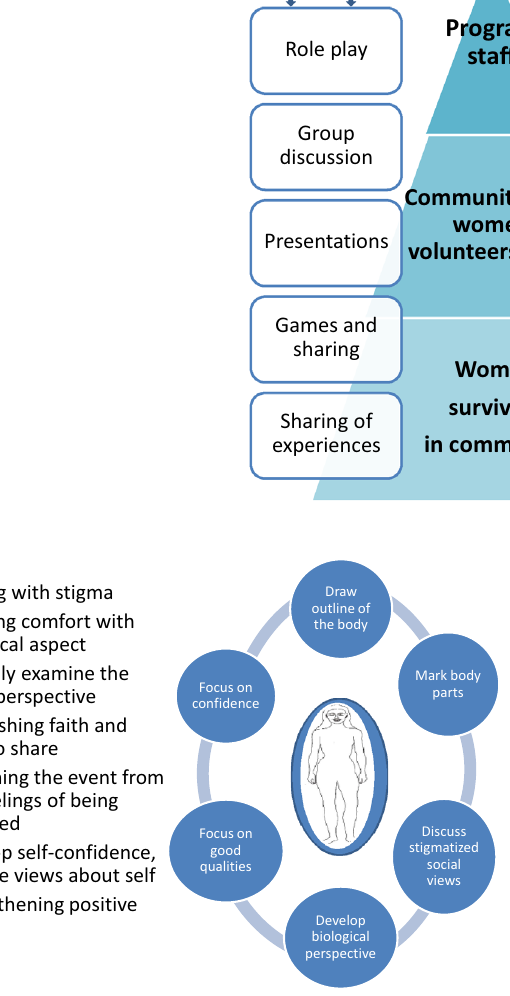
Fig. 2 Body mapping session as a means for empowering women in